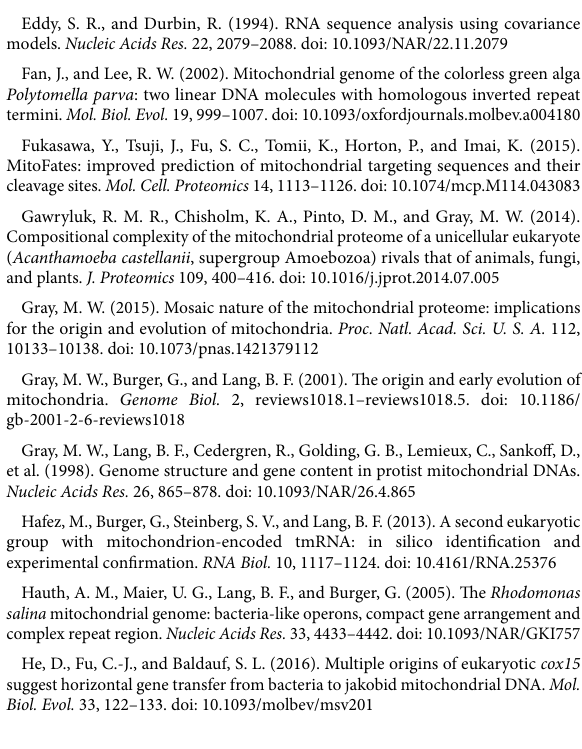
SUPPLEMENTARY FIGURE S1 Phylogenetic trees of cox11 and tufA sequences. Maximum likelihood (ML) trees inferred from the cox11 and tufA alignments are shown in (A,B) , respectively. The eukaryotic sequences (and branches) are shown in blue. Archaeal and bacterial branches are colored orange and gray, respectively. The pink shade indicates nuclear-coded sequences and the right blue shade indicates mitochondrial-coded sequences. The sequences identified in the mitochondrial genome of Microheliella maris are shown in red. Only ML bootstrap values/Bayesian posterior probabilities equal to or > 50% / 0.90 are shown. SUPPLEMENTARY FIGURE S2 Phylogenetic trees of ccmA, ccmC, and ccmF sequences. Maximum likelihood (ML) trees inferred from ccmA, ccmC, and ccmF alignments are shown in (A-C) respectively. The eukaryotic sequences (and branches) are shown in blue. Archaeal and bacterial branches are colored orange and gray, respectively. Sequences identified in the mitochondrial genomes of Microheliella maris , Palpitomonas bilix, and Hemiarma marina are shown in red. Only ML bootstrap values/Bayesian posterior probabilities equal to or > 50% / 0.90 are